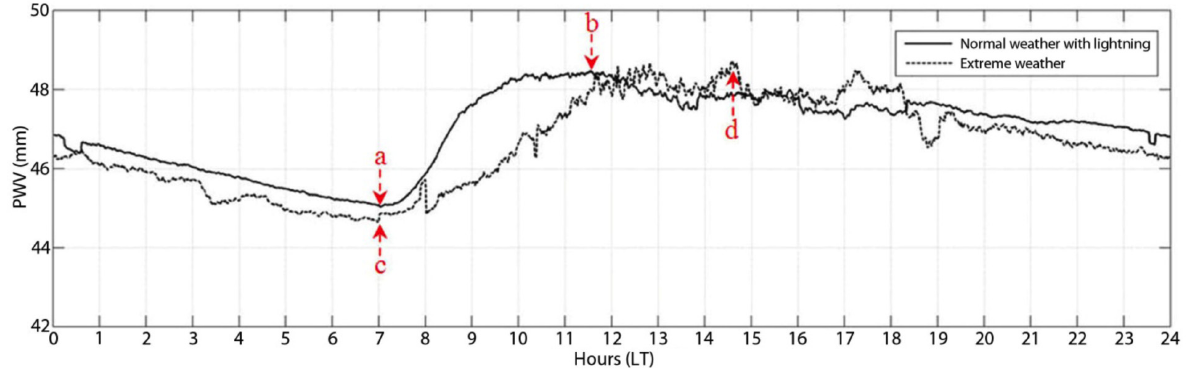
Figure 9. GPS PWV average for normal weather with lightning and extreme weather, where ‘a’ and ‘c’ are the starting points, and ‘b’ and ‘d’ are the peak